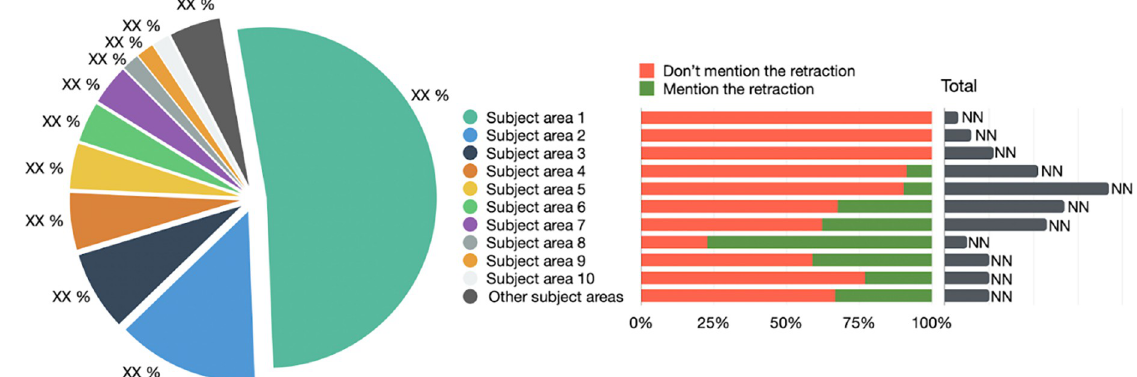
Fig 4. A pie chart used to represent the distribution of the citing entities across the subject areas. The chart shows the 10 most representative subject areas and groups the rest under the “Other subject areas” category. The graphic shows also the absolute number of entities for each category, along with the percentages of entities which have/have not mentioned the